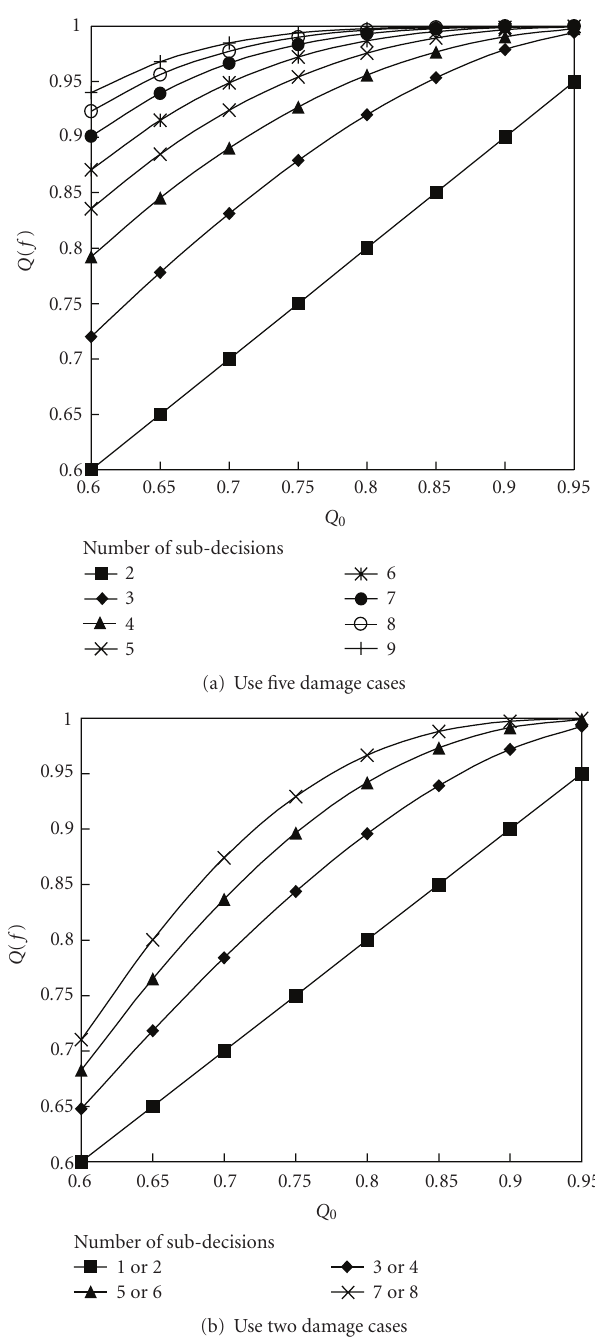
Figure 2: PCS of fusion system versus that of sub-decision system.